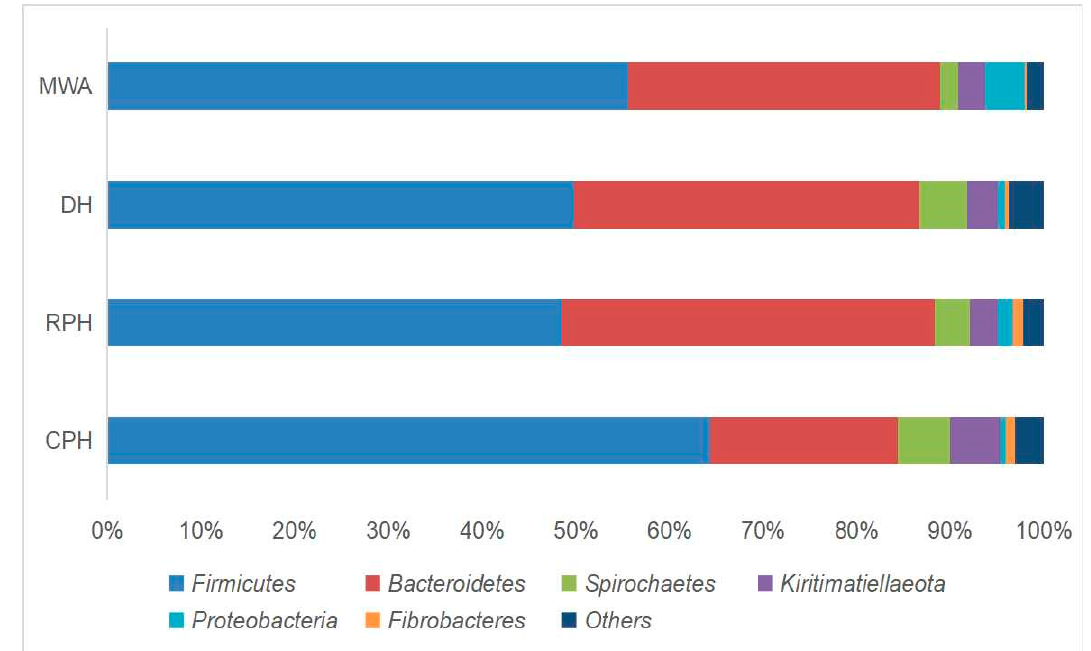
Figure 4. Top relative abundances of phyla, ranked by 1 and 0 orders of magnitude based on RPHs, with relative abundances of the corresponding phyla in CPHs, DHs and MWAs shown. Data were from a study conducted in KNR and PHBC, China, during June 2018.